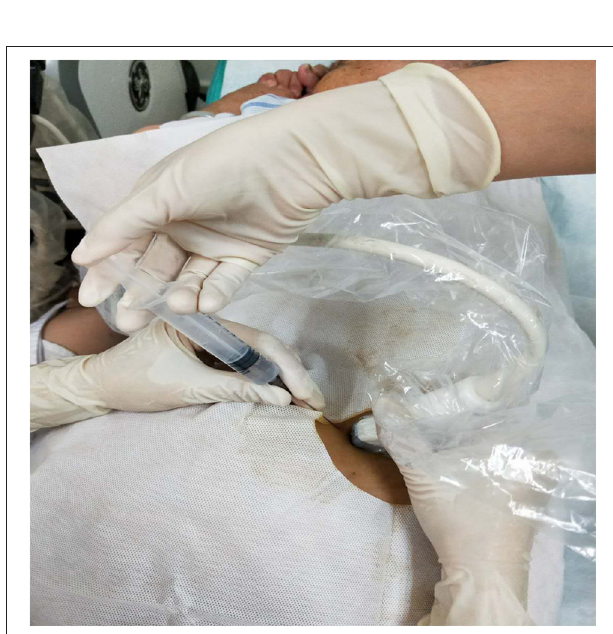
FIGURE 2 | Ultrasound-guided injection of botulinum toxin A into the lateral abdominal muscles. EOM, external oblique muscle; IOM, internal oblique muscle; TM, transverse